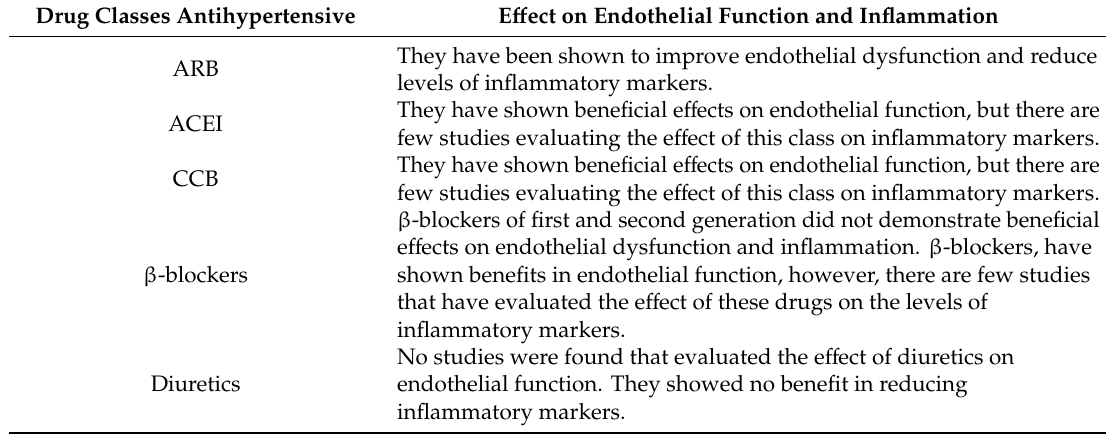
Table 5. E ff ect of di ff erent classes of antihypertensive drugs on endothelial function and inflammation. Drug Classes